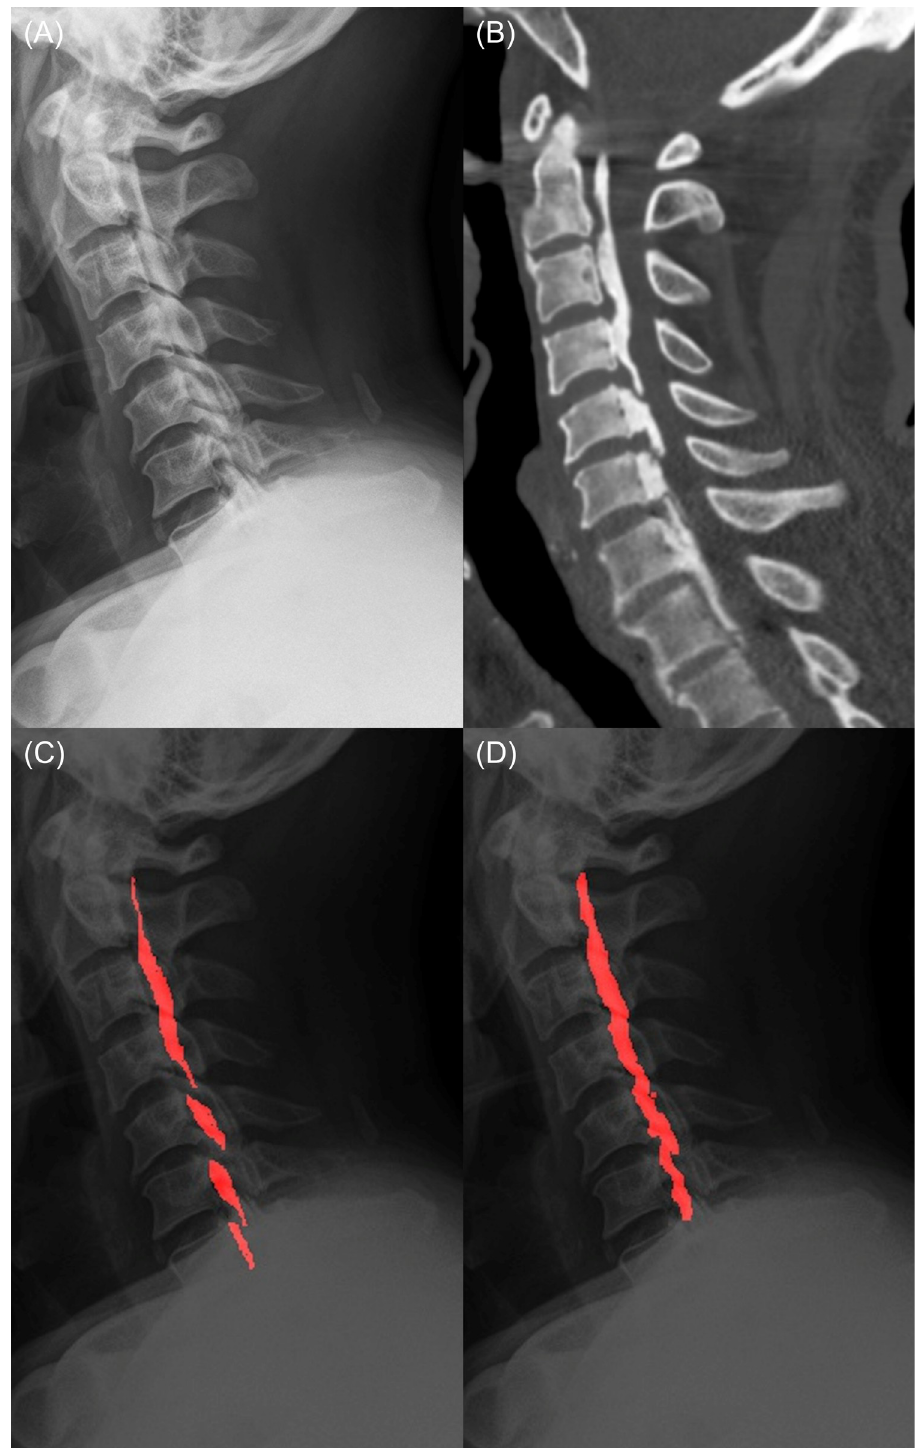
Fig 3. A 65-year-old male patient with mixed-type OPLL. (A) A lateral plain radiograph shows mixed-type OPLL along the posterior side of the vertebra. The lesion at the C7 level is obscured by the shoulder shadow. (b) In the sagittal image of cervical spine CT, ossifications ranging from the C2 to T1 level are clearly demonstrated (window width = 2000 HU, window level = 500 HU). (c) OPLL lesions annotated by a radiologist on the plain radiograph. (d) In the resulting image inferred by the deep-learning model, OPLL lesions at the C2-6 levels are well predicted, but the lesion located at the C7 level was not detected by the model. OPLL, ossification of the posterior longitudinal ligament. https://doi.org/10.1371/journal.pone.0267643.g003 PLOS ONE | https://doi.org/10.1371/journal.pone.0267643 April 27,